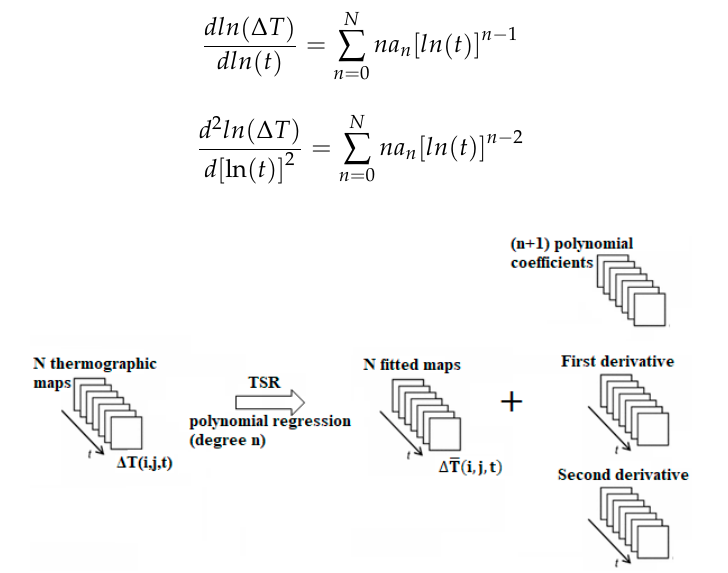
Figure 3. Defect detection by the Thermal Signal Reconstruction (TSR) method, logarithmic derivation.